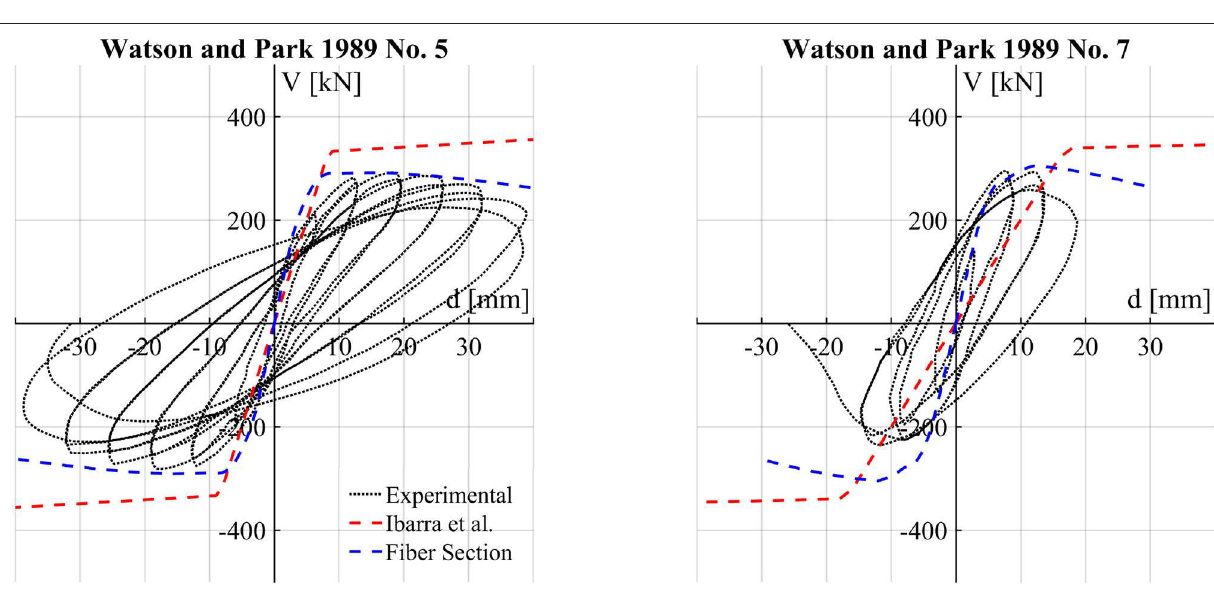
Frontiers in Built Environment |